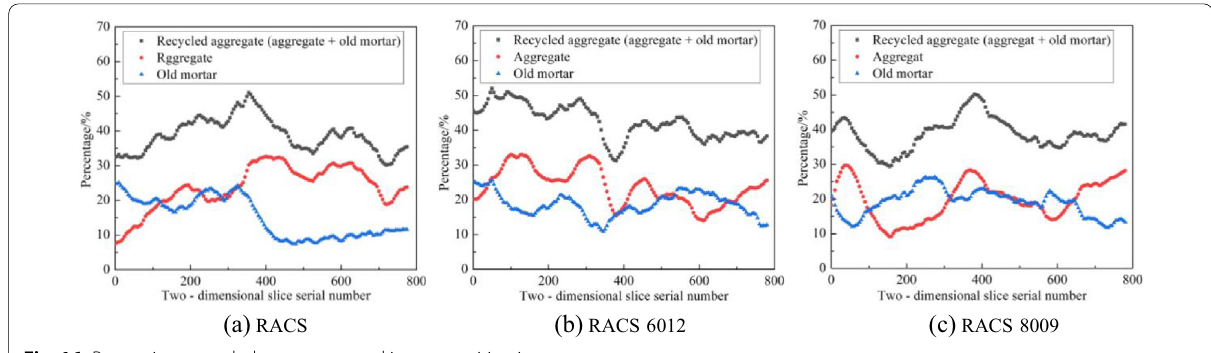
Fig. 16 Proportions recycled aggregates and its composition in